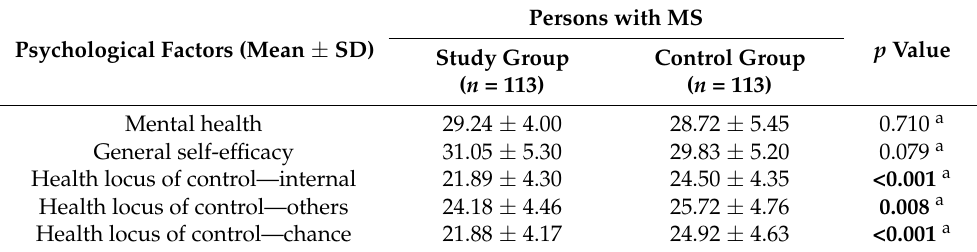
Table 2. Comparison of mental health and psychological factors of persons with MS studied in 2020 and control group studied in